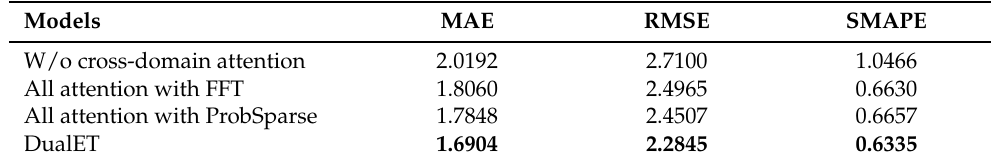
Table 4. Different attention modules. W/o means